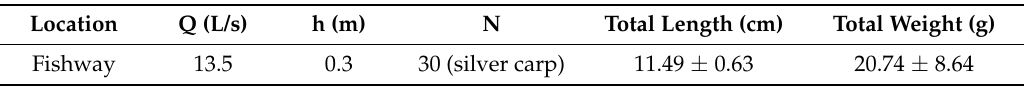
Table 1. Detailed description of experimental conditions.